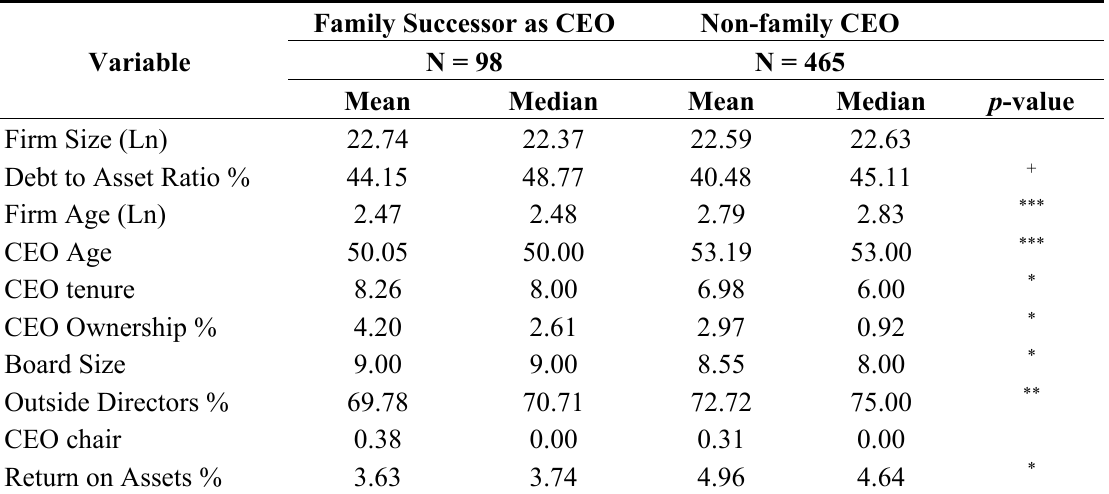
Table 5. Descriptive Statistics Given CEO